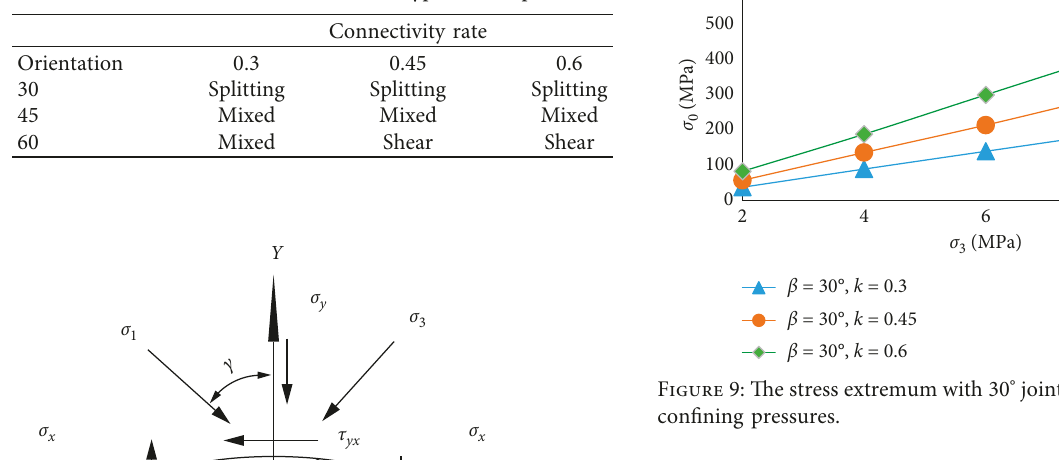
Table 3: Failure modes for different types of